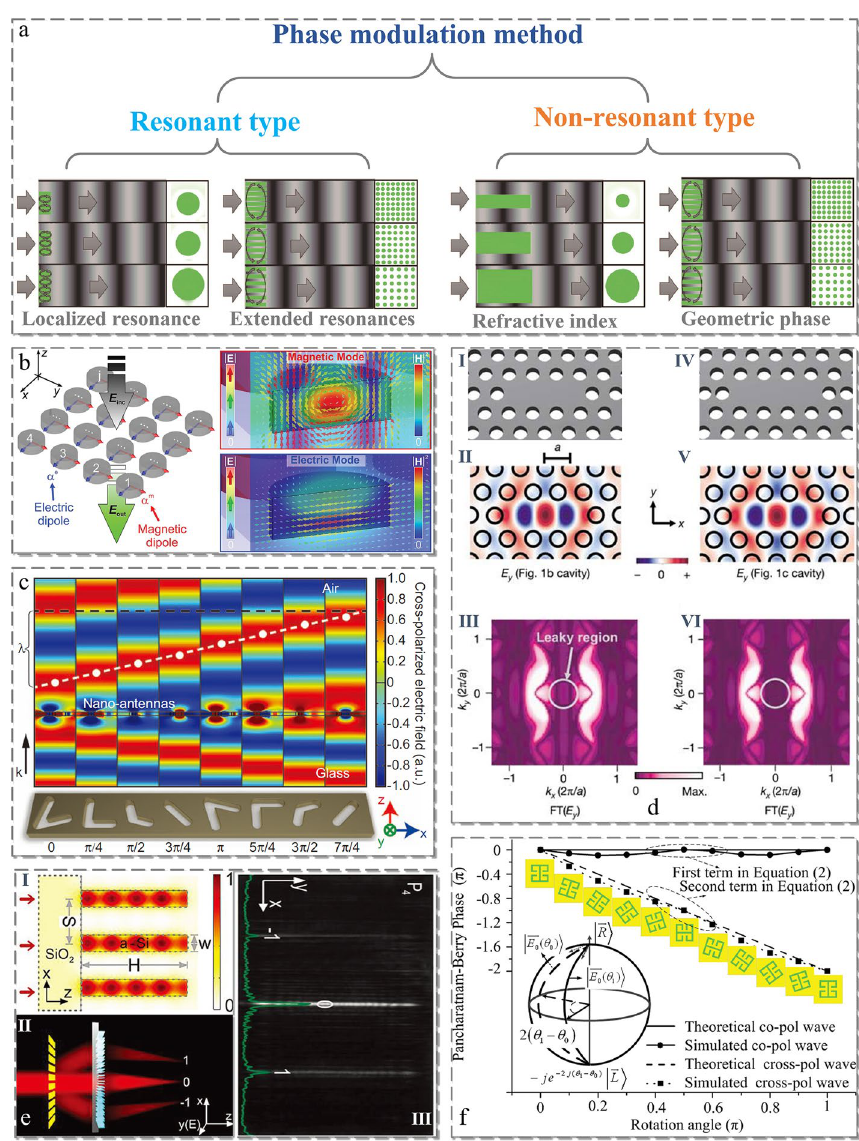
Fig. 3 (a) High-level schematic of various of nanostructures to achieve phase control in metasurfaces. (b) Schematic of Mie resonant: an (infinite) array of nanodisks represented as electric and magnetic dipoles with polarizabilities α e and α m for x -polarized incident light. Electric (colored arrows) and magnetic (plain color-coded) field distributions of the magnetic (right-top) and electric (right-bottom) mode of a silicon (Si)-nanodisk metasurface. (c) Schematic designs and the results of full-wave simulations of the individual Babinet-inverted nanoantennas. The pseudo-color field map indicates the cross-polarized light scattered from each nano-antenna. (d) Photonic nanocavities using a two-dimensional (2D) photonic-crystal slab: (I) Starting cavity structure with three missing air rods (I) and designed cavity structure created by displacing the air rods at both edges (IV); (II and III) and (V and VI) Electric field profile and 2D Fourier transform spectrum, respectively, for the designed cavity shown in (I) and (IV). (e) Schematic of the Fourier meta-lens (I) and magnetic intensity distribution of the dielectric waveguide (II). Intensity distribution in the focal plane (III). (f) PB geometric phase variation of the co-polarization (solid lines) and cross-polarization (dashed lines) transmitted wave, as a function of the orientation angle of the unit cell. The inset shows a visualization of the PB phase on the Poincaré sphere. (a) Reproduced with permission [96]. Copyright 2019, Optical Society of America (OSA). (b) Reproduced with permission [97]. Copyright 2015, Wiley-VCH. (c)